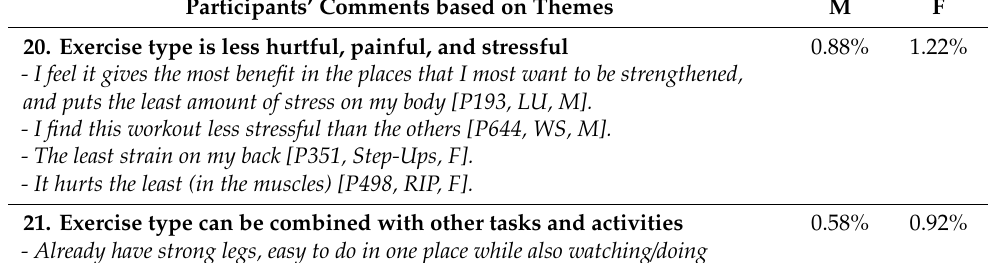
Table A1. Cont . Participants’ Comments based on Themes